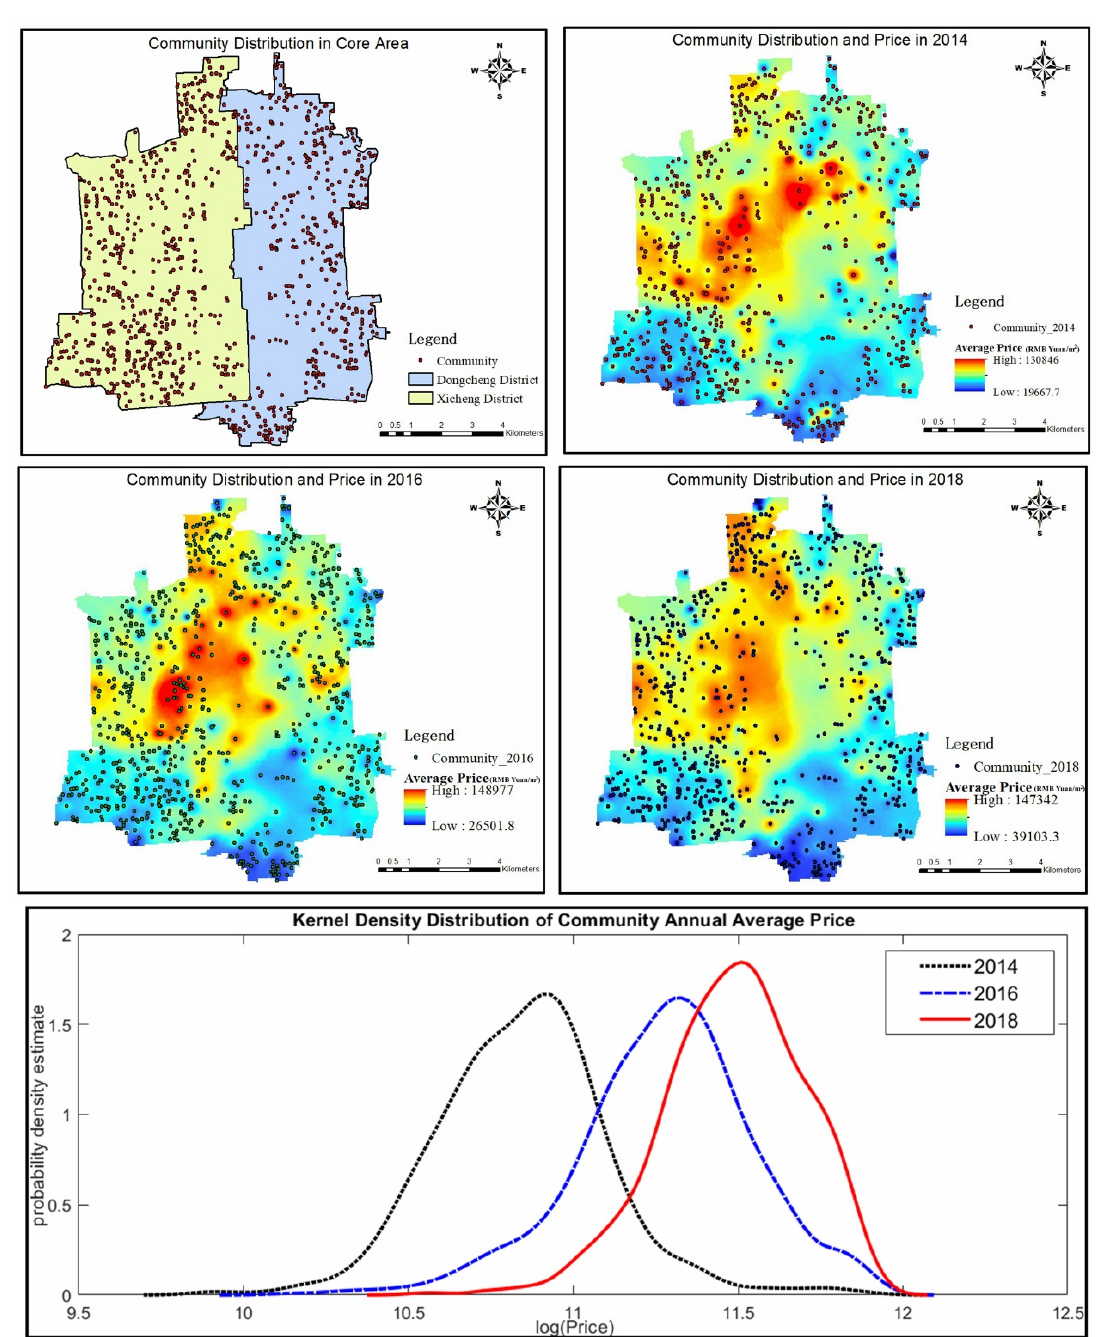
Figure 2. Spatial distribution and kernel density distribution of community annual average